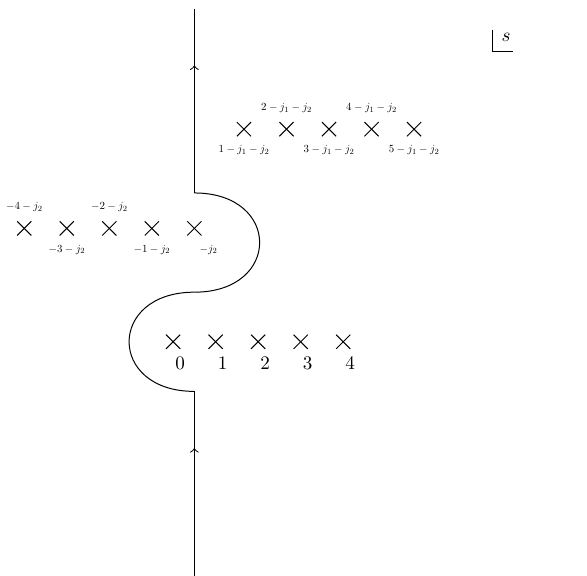
Figure 4 . Integration contour C K in the s -plane for the kernel in (4.16). The poles come from Γ( − s )Γ(1 − j )Γ( j + s ) . In drawing the plot we used the fact that Re[ j 1 − j 2 − s 2